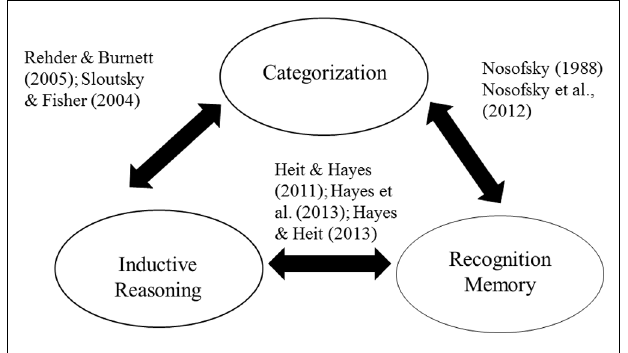
FIGURE 3 | Schematic representation of the empirical relations between recognition memory, inductive reasoning, and categorization, with example studies